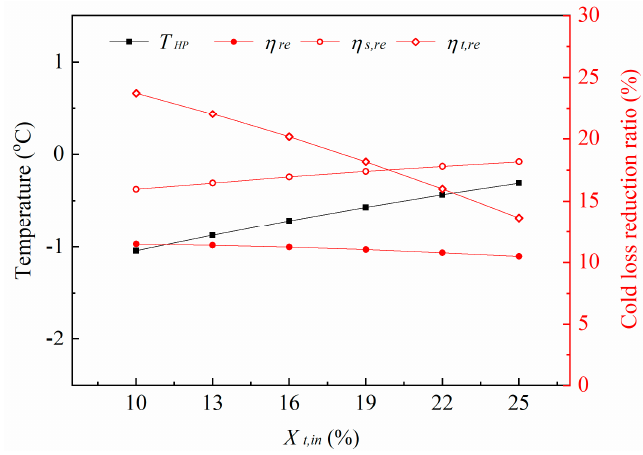
Figure 16. Behaviors of improved refrigerator versus X s,in when X t,in is 16%.